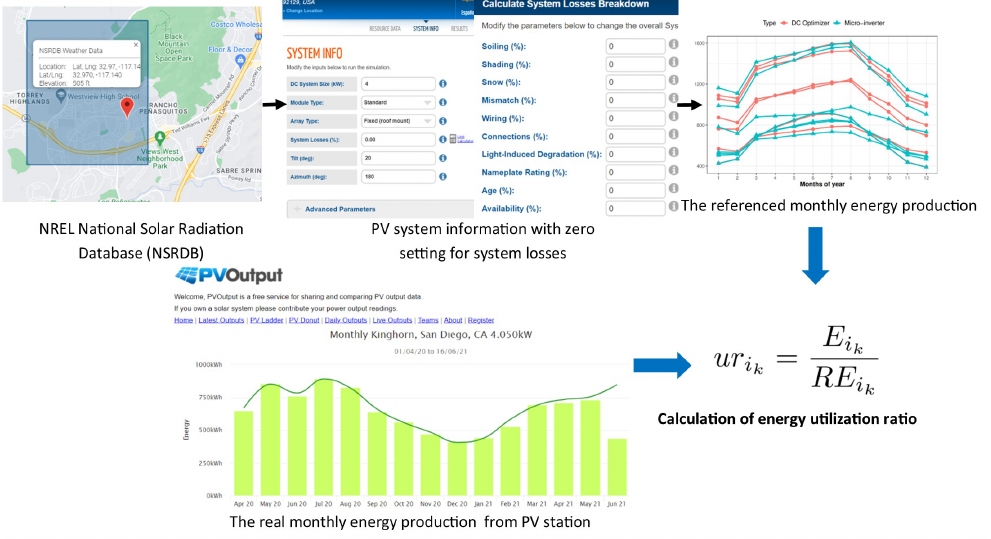
Figure 2. The flowchart of estimating the referenced monthly energy production based on the PVWatt tool and calculating the energy utilization ratio.